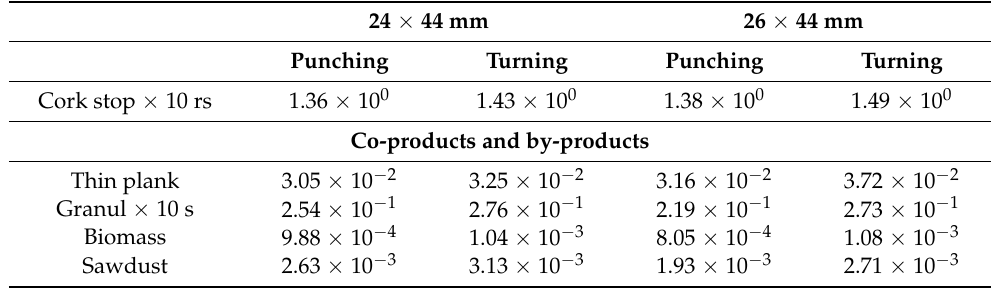
Table 5. Global environmental impact of natural cork stopper production (kg CO 2